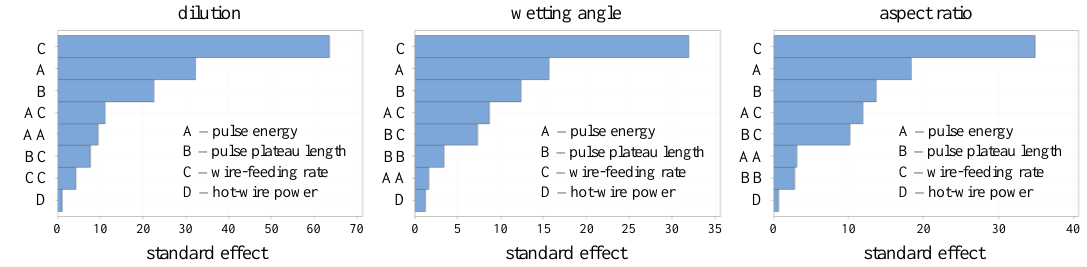
Figure 17. Pareto charts for the best-fit regression functions.